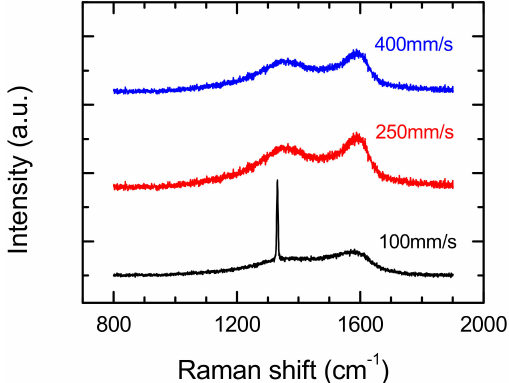
Figure 9. E ff ect of scan speed on Raman spectra from modified surface of polycrystalline diamond.